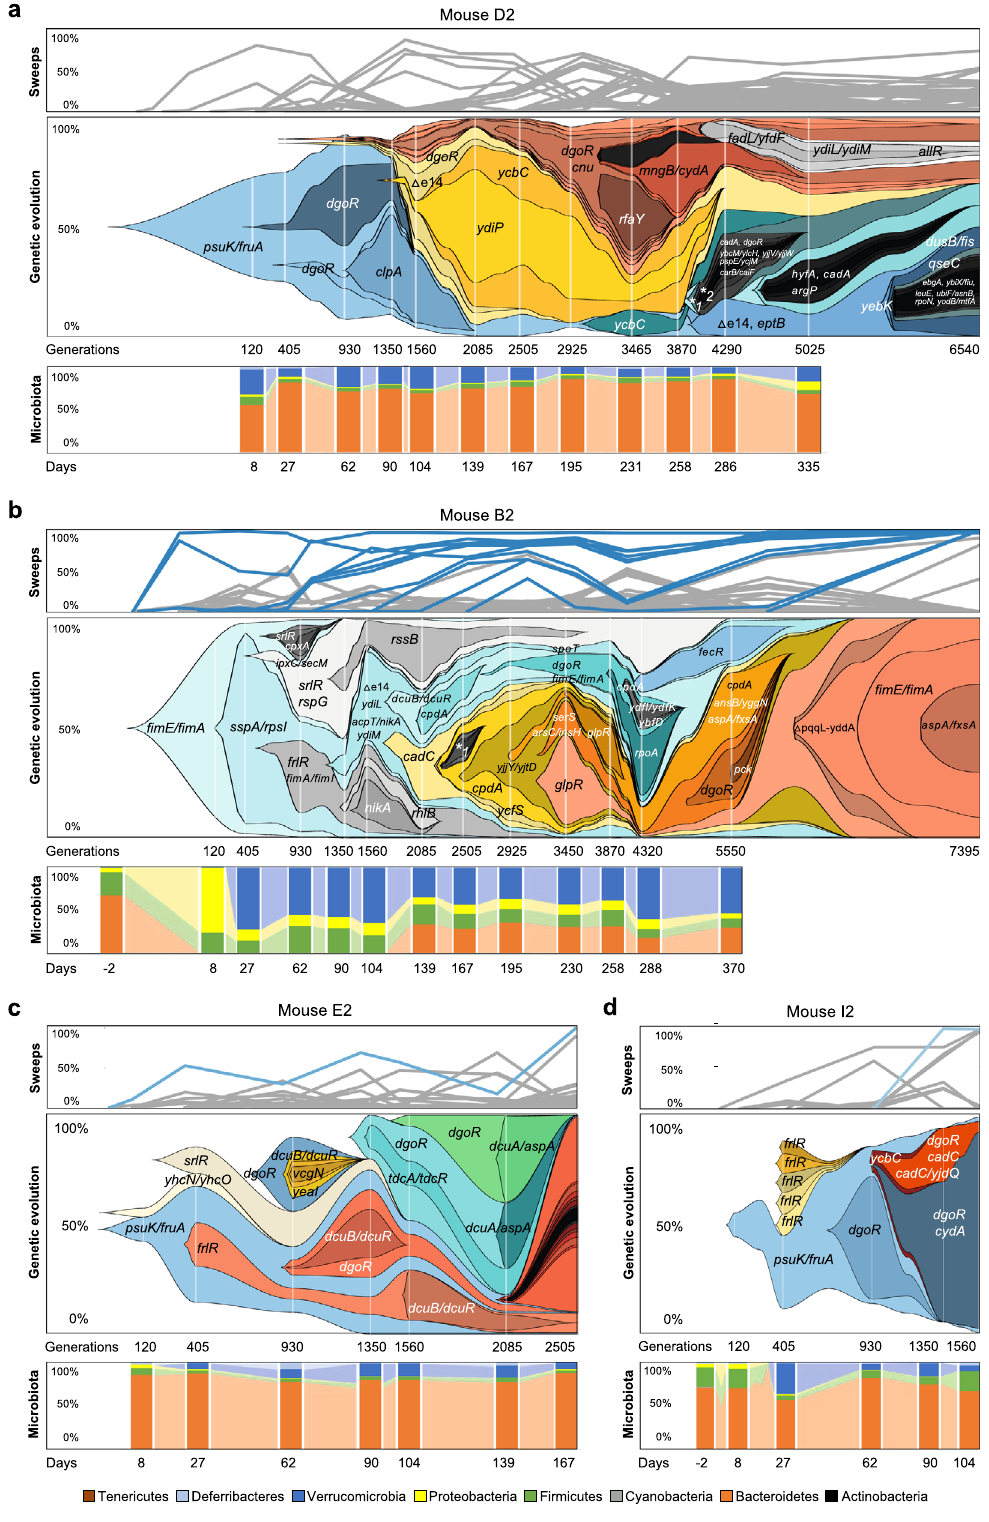
Fig.2|Evolutionofinvader E.coli intheabsenceoftheresident.a – d Frequency of the mutations identi fi ed in the invader E. coli population across time in mouse D2,B2,E2andI2(toppanels)andcorrespondingMullerPlotsshowingthespreadof mutations observed in each mouse (middle panels). Microbiota composition